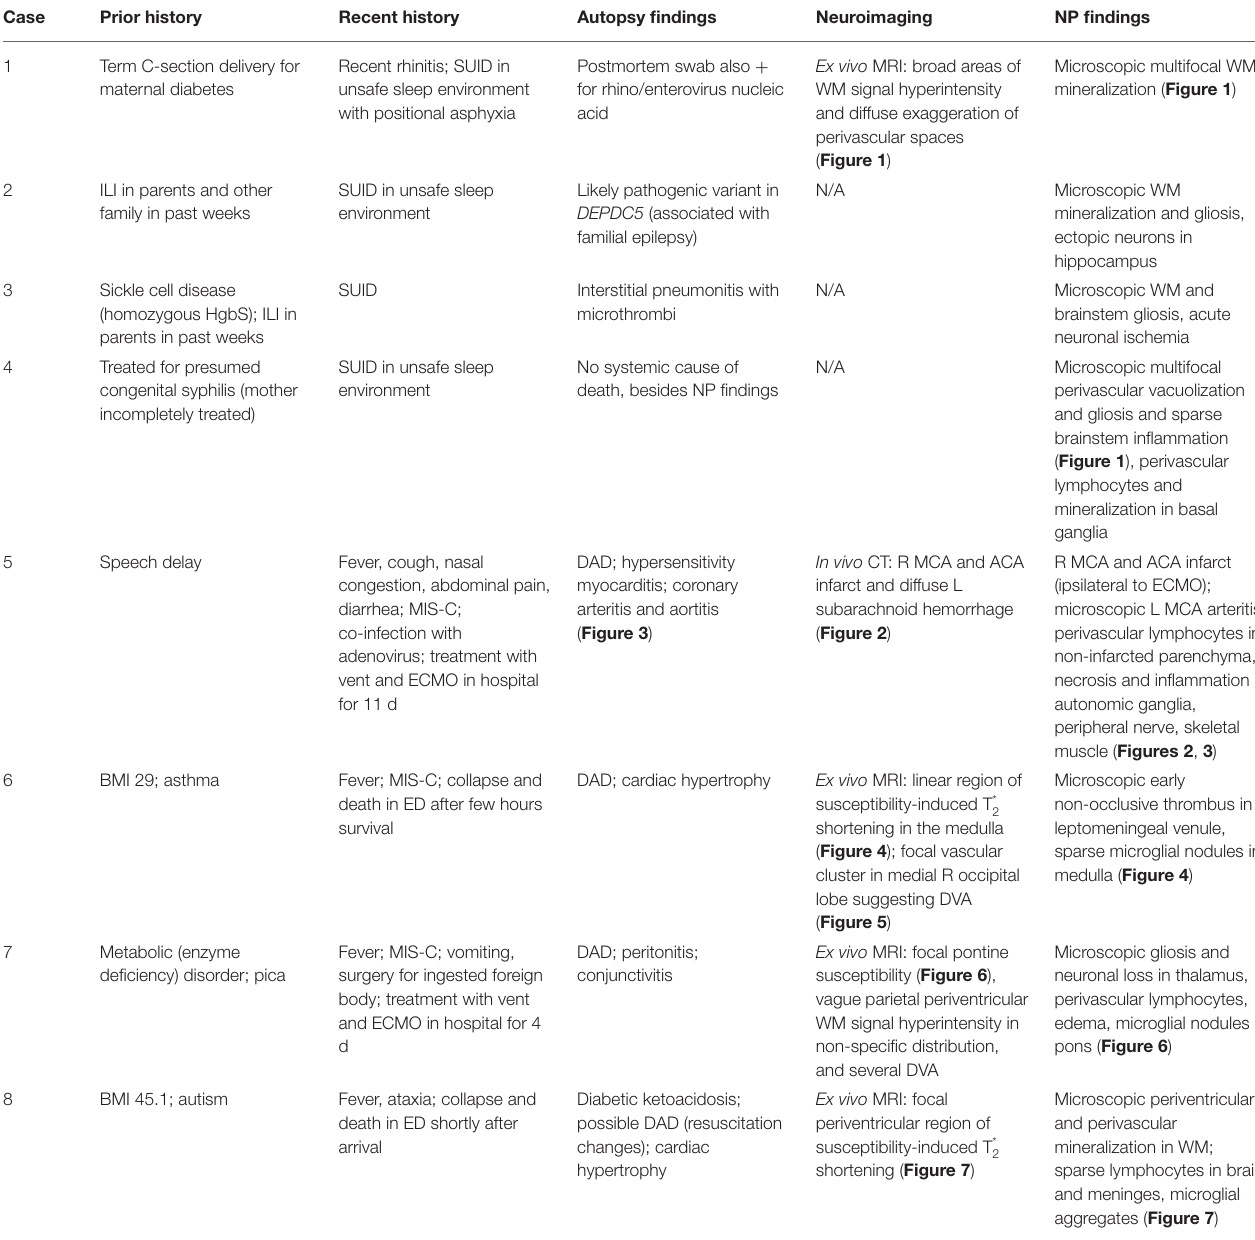
TABLE 2 | Clinical characteristics, in vivo CT and ex vivo MR neuroimaging, and autopsy findings in this